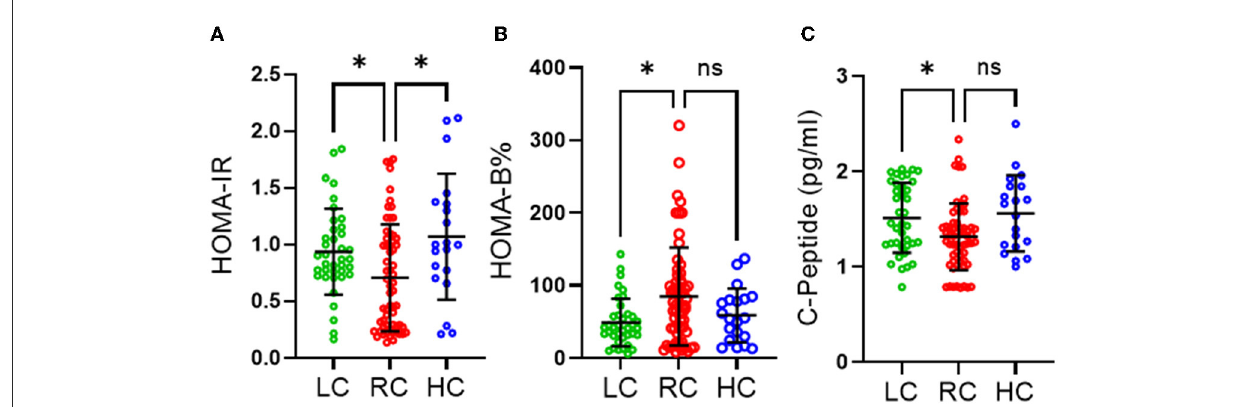
FIGURE1 Effects of different levels of carbohydrate intake on glucose homeostasis. (A) HOMA-IR homeostasis model assessment of insulin resistance, (B) HOMA-beta homeostasis model assessment of β -cell function (C) C-peptide section. Data are expressed as mean ± SD. Data analyzed by exact Kruskal-Wallis test. ns, non-significant, * P ≤ 0.05. Low carbohydrate (LC) (those consuming < 45% of daily energy percentage) represented in green, recommended range of carbohydrate (RC) (those consuming 45–65% of daily energy percentage) represented in red and high carbohydrate (HC) (those consuming higher than 65% of daily percentage) represented in